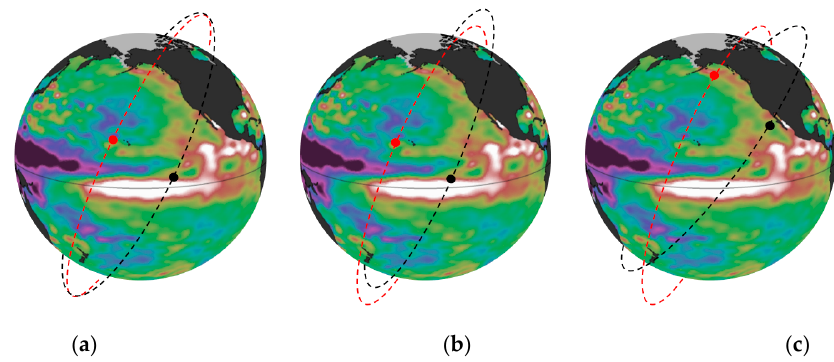
Figure 4. LB-IRA satellite formation and the helix orbit configuration. ( a ) Maximum separation at equator, intersects near the poles, ( b ) maximum separation at equator, the small eccentricity offset causes different heights of perigee, snd ( c ) optional rotation of the perigee to achieve proper baseline configuration near the high-latitude region.